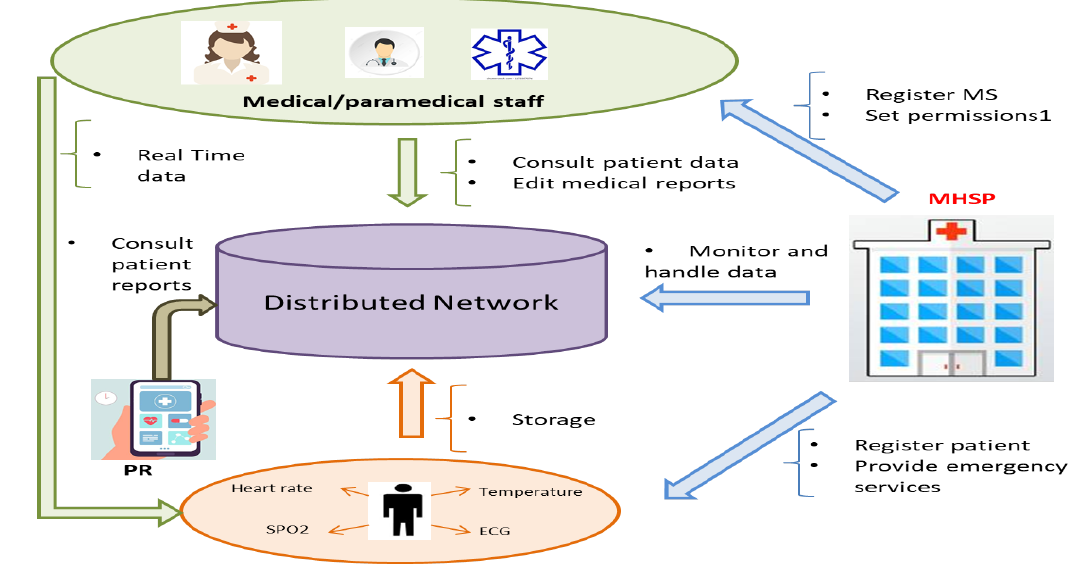
Figure 1. System